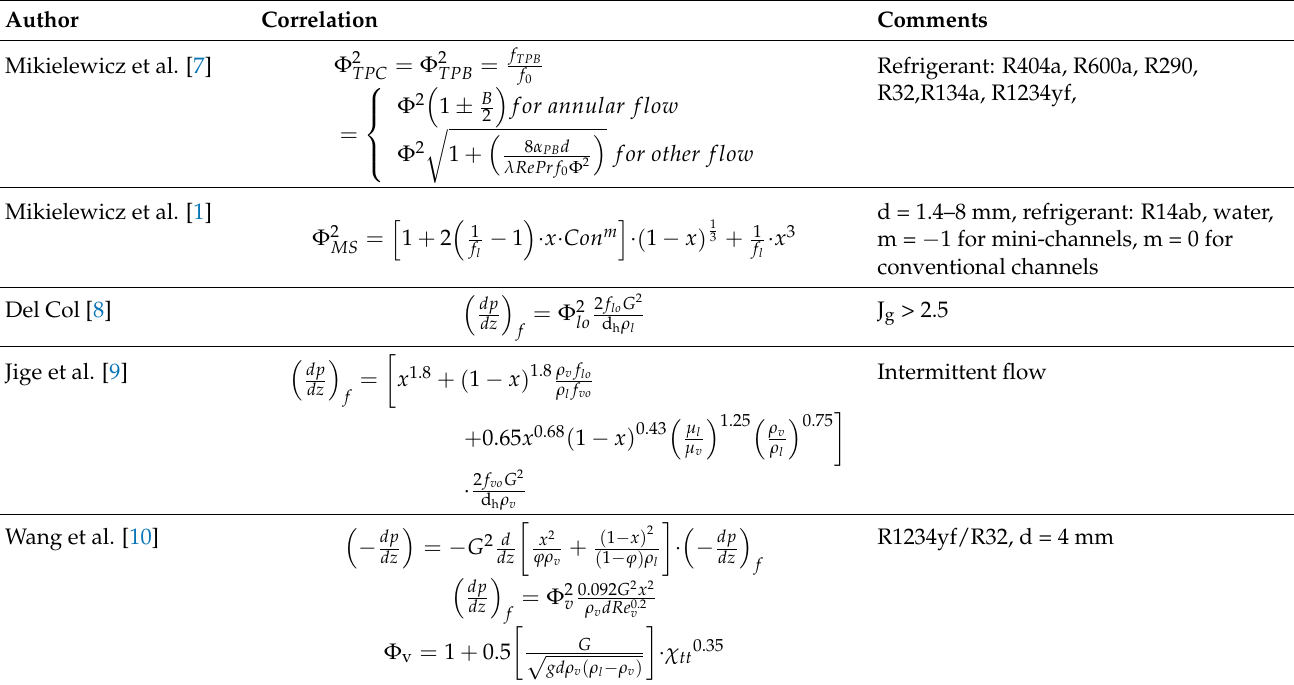
Table 1. Correlation described pressure drops during the condensation process of new refrigerants for different flow regimes.